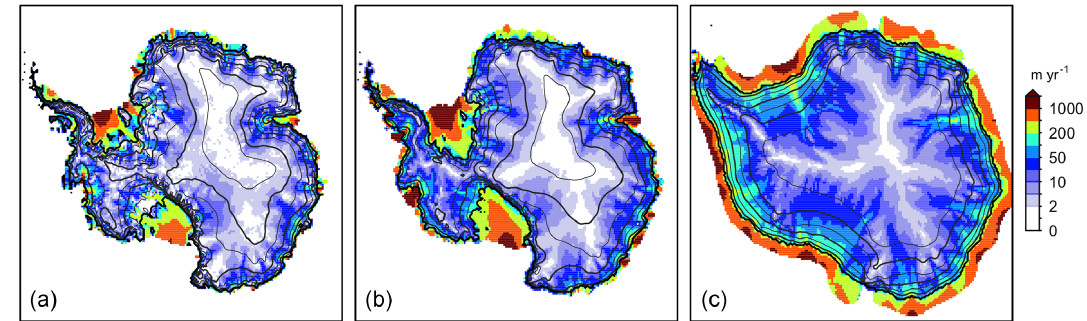
Figure 10. (a) Antarctica present-day ice sheet configuration and surface velocities from observations, compared to (b) a steady-state simu- lation with Yelmo. (c) In contrast, Antarctica glacial configuration and surface velocities simulated by Yelmo. Simulations were performed at 32km resolution. The colors show surface velocity in meters per year, and the dark grey contours show surface elevation in 500m intervals (thick lines correspond to 1000, 2000 and 3000m above sea level). The black line shows the grounding-line position.